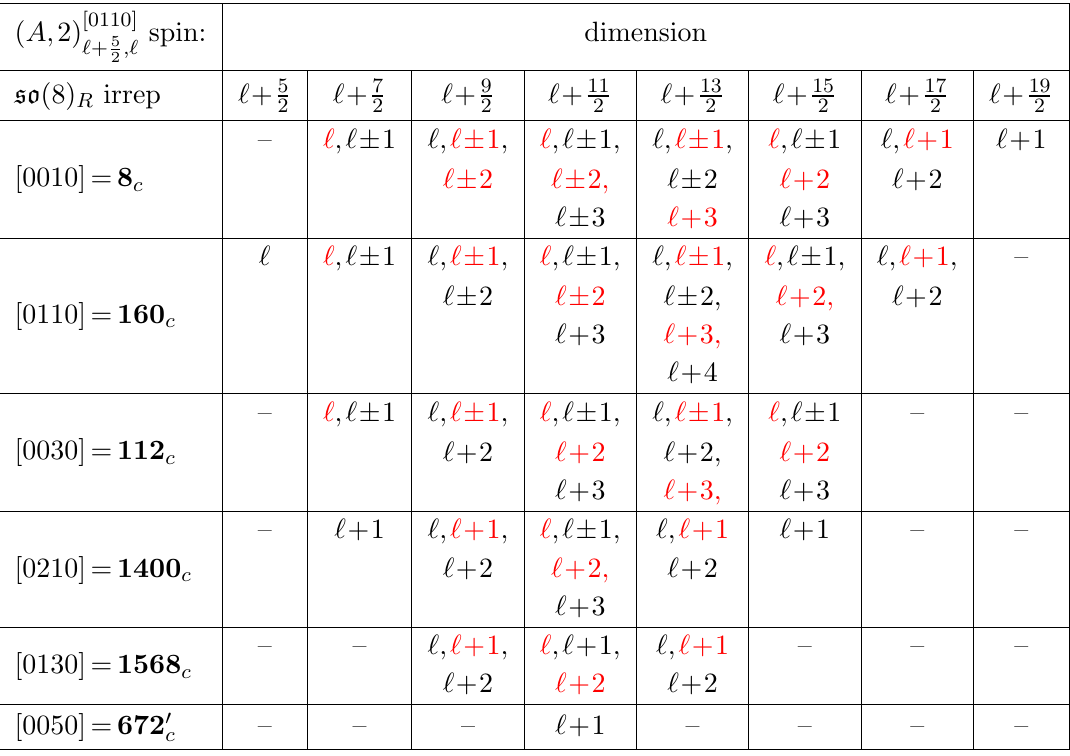
Table 17 . All possible conformal primaries in S 2 (cid:2) S 3 corresponding to the ( A; 2) [0110] formal multiplet. For ‘ = 0 ; 1 ; 2, the conformal primaries with negative spin should be omitted.